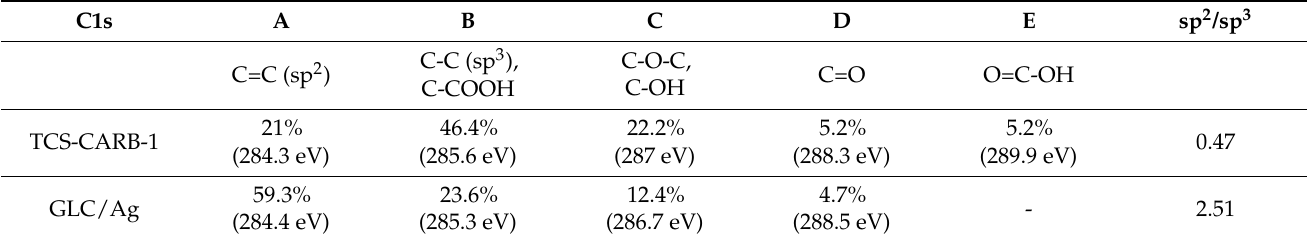
Table 1. The percentage of carbon bonds in the target material and in the carbon film deposited on silver.